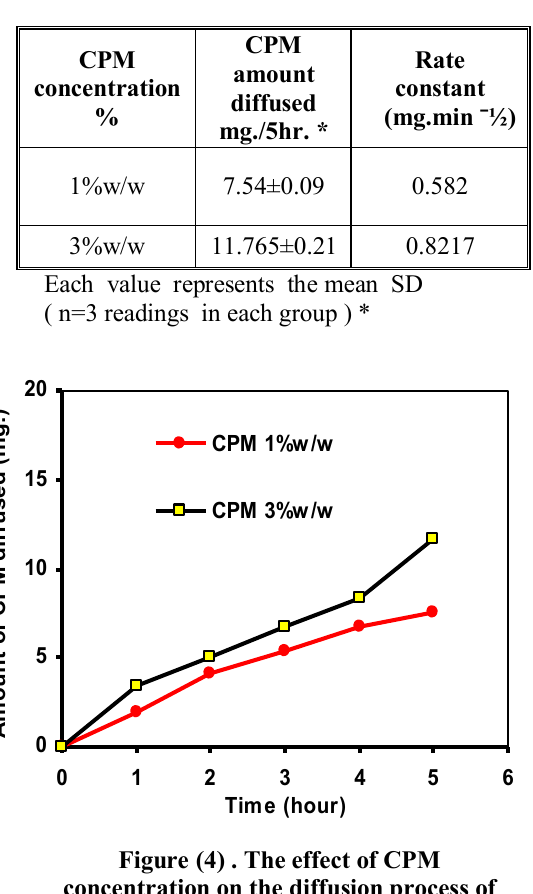
Table 3. Effect of CPM concentration on the diffusion rate constant (K)